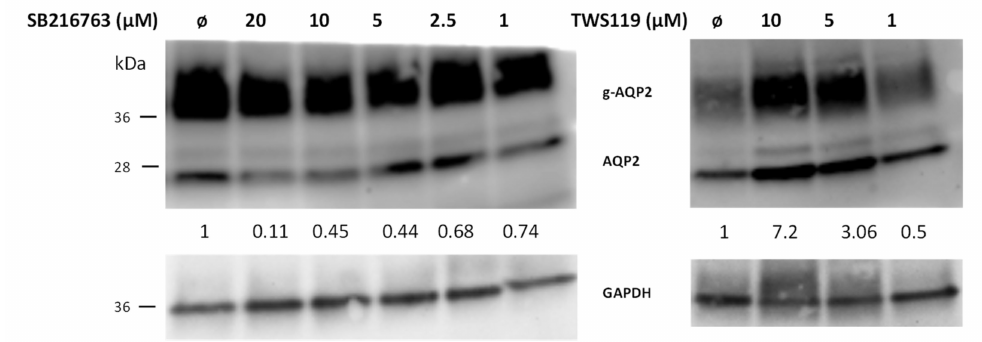
Figure 3. SB216763 and TWS119 have di ff erent e ff ects on Aqp2 expression. IMCD cells were left untreated and treated for 24 h with di ff erent concentrations of GSK3 α / β SB216763 (left panel, concentrations as indicated) or treated for 24 h with di ff erent concentrations of GSK3 β TWS119 (right panel, concentrations as indicated). The cells were lysed and the expression of AQP2 was analyzed by Western blot. Afterwards the antibodies were stripped, and the membrane was incubated with GAPDH. The numbers indicate the relative Aqp2 signal intensities compared to untreated cells (n =